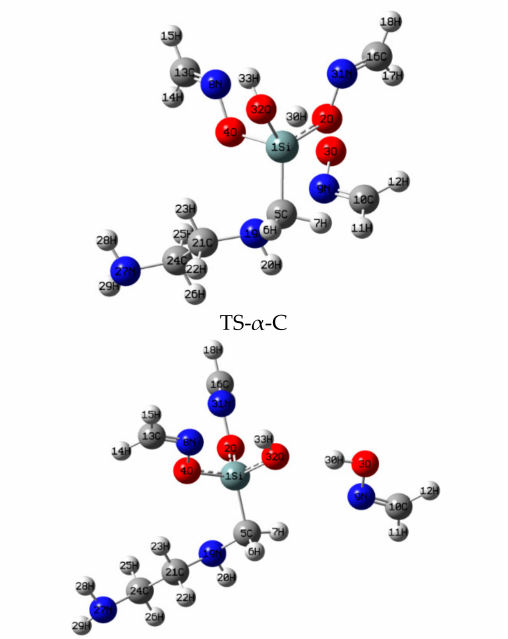
Figure 1. Geometries of stationary points of the reaction between α -ethylenediaminemethyl trimethyl-ketoxime silane (EAMOS) and H 2 O at B3LYP/6-311G**